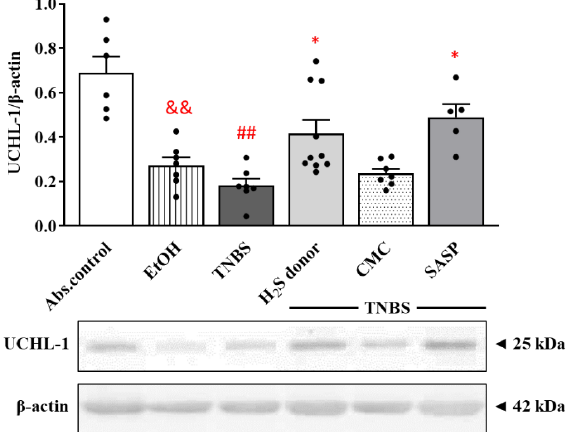
Figure 7. Changes in the colonic expression of UCHL-1 in different treated groups. Absolute control (no treatment); EtOH (50% ethanol, the solvent of TNBS); TNBS (2,4,6-trinitrobenzenesulfonic acid enema); H 2 S donor (TNBS + 18.75 μM/kg/day Lawesson’s reagent); CMC (TNBS + 0.5% carbox- ymethylcellulose, the vehicle of Lawesson’ s reagent); SASP (TNBS + 50 mg/kg/day sulfasalazine, as a positive control). Results are presented as mean + S.E.M.; n = 5 – 10/group; one-way ANOVA, Holm – Sidak post hoc test, ## p < 0.001 absolute control vs. TNBS; * p < 0.05 TNBS vs. TNBS +